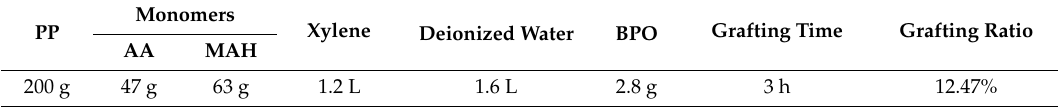
Table 1. The optimal combination of parameters for suspension graft polymerization.